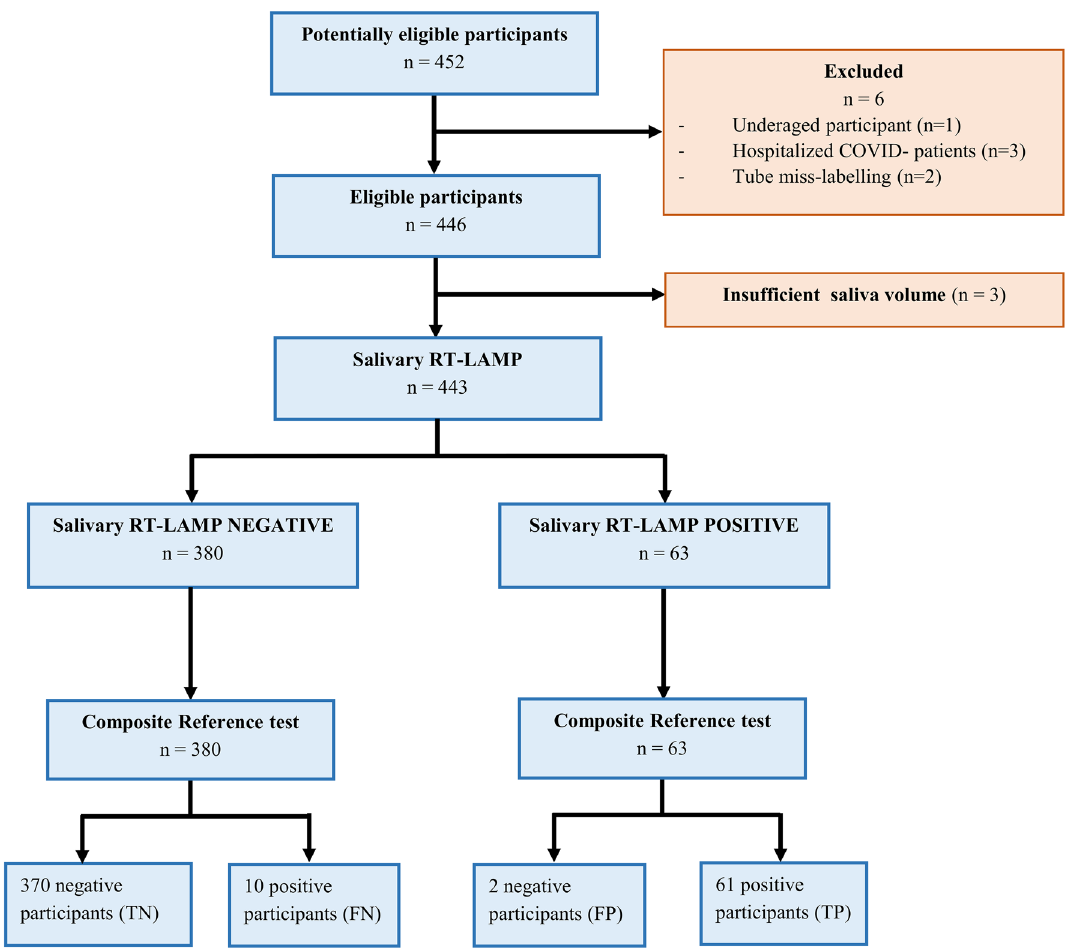
Figure 1. Study flow diagram. RT-LAMP, reverse transcription loop-mediated isothermal amplification; COVID, Coronavirus disease; TN, true negative; FN, false negative; TP, true positive; FP, false positive for salivary